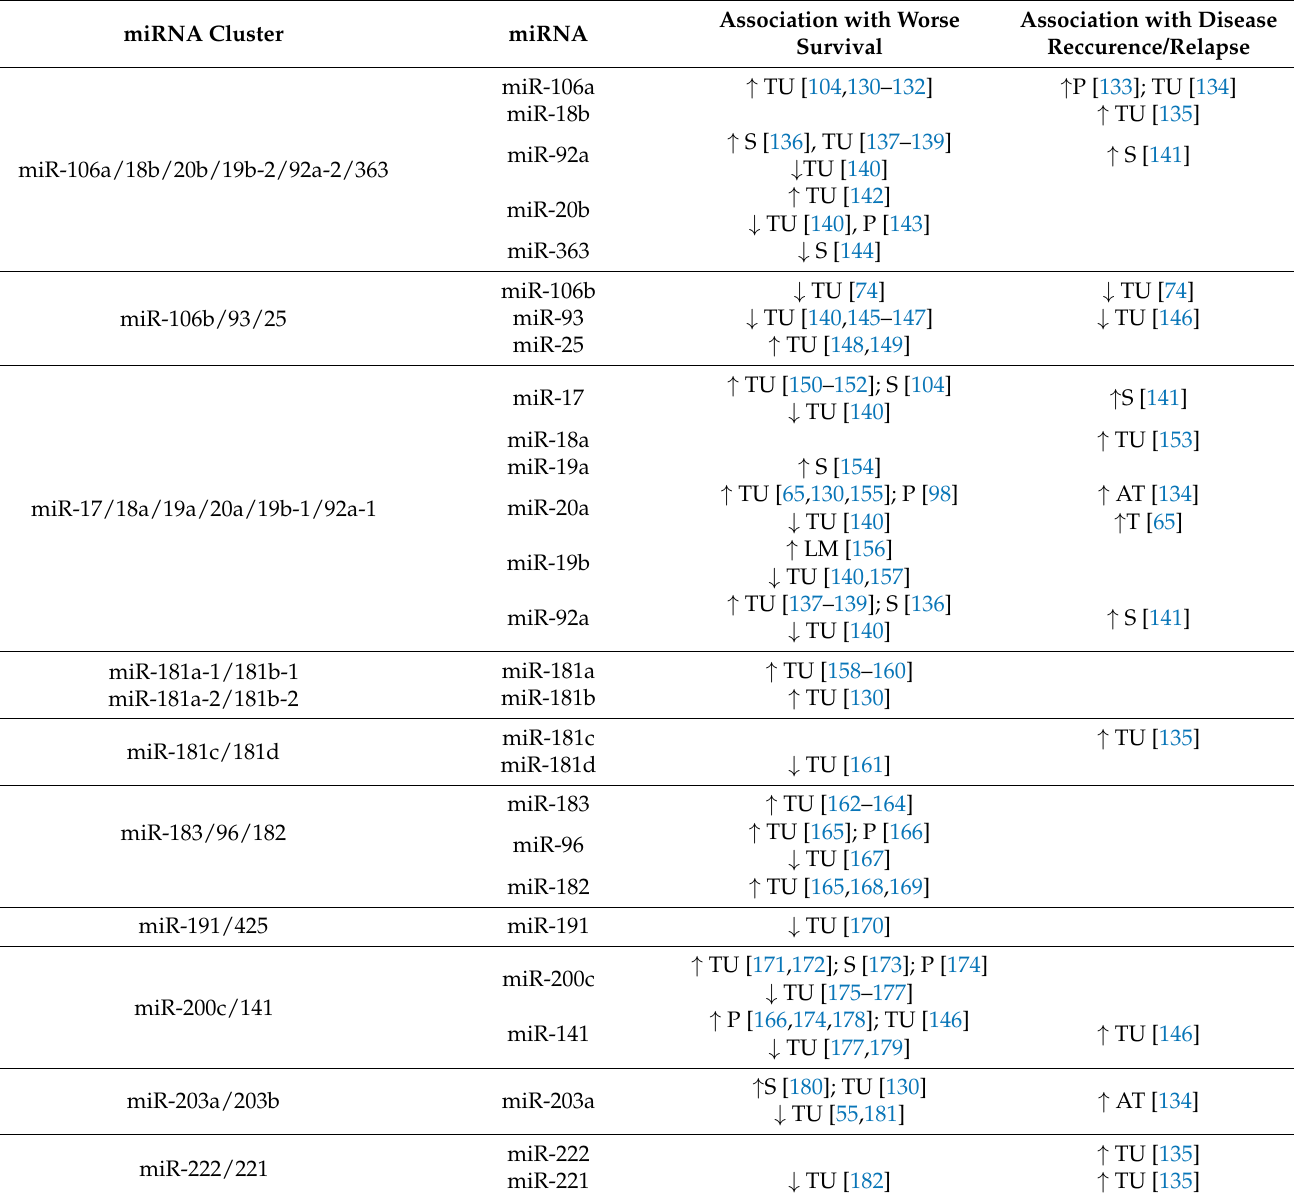
Table 5. miRNAs associated with worse survival or disease recurrence/relapse. miRNA Cluster miRNA